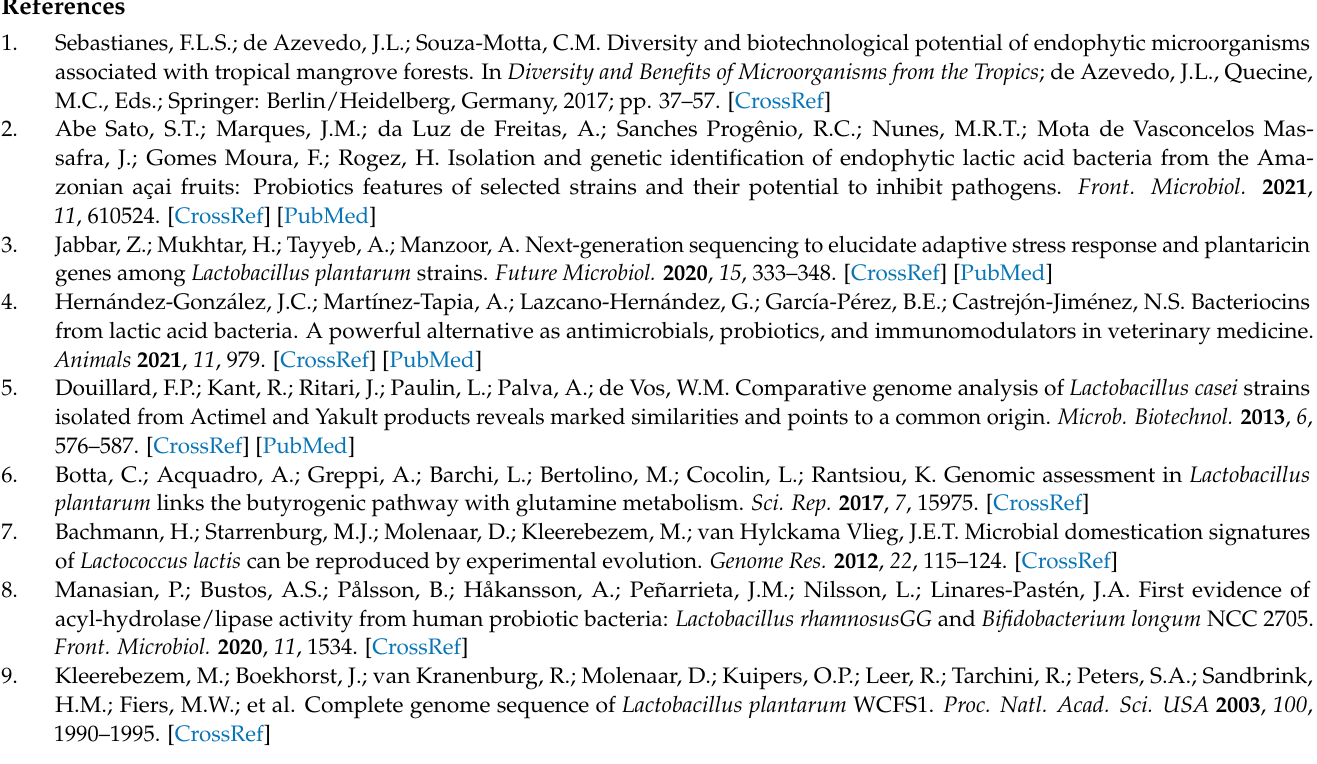
Table S2: Base change count for every SNP of (A) UTNGt21A and (B) UTNGt2; Table S3: Variant strains; Table S4: Variant annotation results of genes related to strains’ adaptation to different stressors; Figure S1: (A) Circular and (B) linear representation of the whole-genome comparison of L. plantarum UTNGt21A, UTNGt2, and WCFS1; Figure S2: Distribution and type of IS elements annotated with EggNOG and the ISsaga web tool; Figure S3: (A) Pairwise protein sequence alignment of putative bacteriocin from UTNGT21A and enterolysin_A from UTNGt21O and Enterococcus faecalis (NCBI accession no. AGG79281.1), with Clustal WS (v.2.0) retrieved from Jalview; (B) average distance calculated based on percentage similarity between sequences; Figure S4: Different expression profiles of S. aureus ATCC1026 treated with different peptide extracts; Figure S5: The effect of 0.3% bile on strain